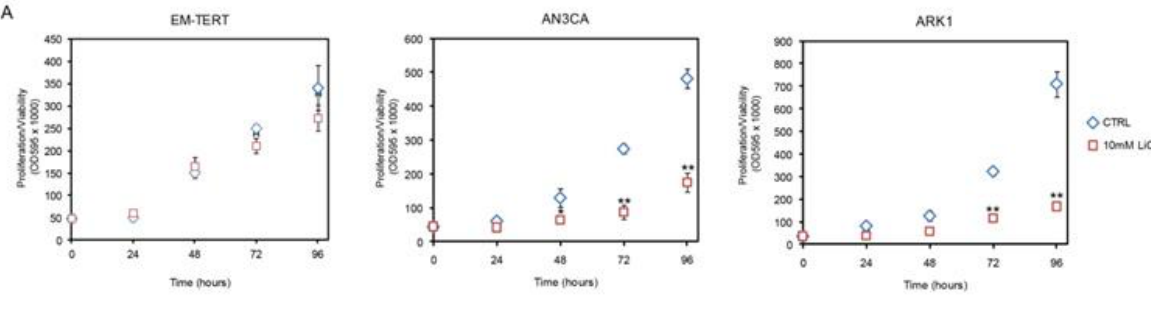
Figure 1. Growth inhibitory effects of LiCl on endometrial cancer cell